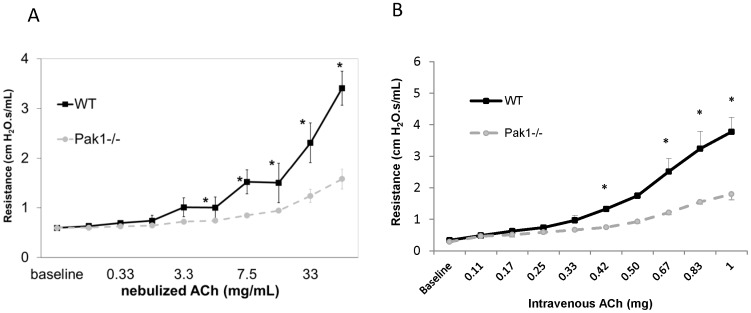

In vivo airway reactivity of Pak1−/− mice was lower than that of WT mice to aerosolized (A) and intra-venous (B) acetylcholine.Resistance in response to increasing concentrations of aerosolized acetylcholine (ACh) for wild-type (WT; N = 8) and Pak1−/− mice (N = 8) (A); values are means ± SEM. There was no difference in resistance at baseline. When analyzed by repeated measures ANOVA, resistance increased with increasing ACh dose (p<0.0001), Pak1−/− mice had a significantly smaller slope of the dose response curve (p<0.03), and a significantly smaller increase in resistance compared to WT mice (p<0.03). Post-hoc analysis demonstrated Pak 1−/− compared to WT mice had significantly smaller resistances at all ACh concentrations ≥7.5 mg/ml (p<0.05). Resistance in response to increasing concentrations of intravenous acetylcholine (ACh) for wild-type (WT; N = 4) and Pak1−/− mice (N = 4) (B); values are means ± SEM. There was no difference in resistance at baseline. When analyzed by repeated measures ANOVA, resistance for Pak1−/− mice increased less with increasing ACh dose (p<0.0001) compared to WT mice. Post-hoc analysis demonstrated Pak1−/− compared to WT mice had significantly lower resistances at ACh concentrations ≥0.42 mg (p<0.05).